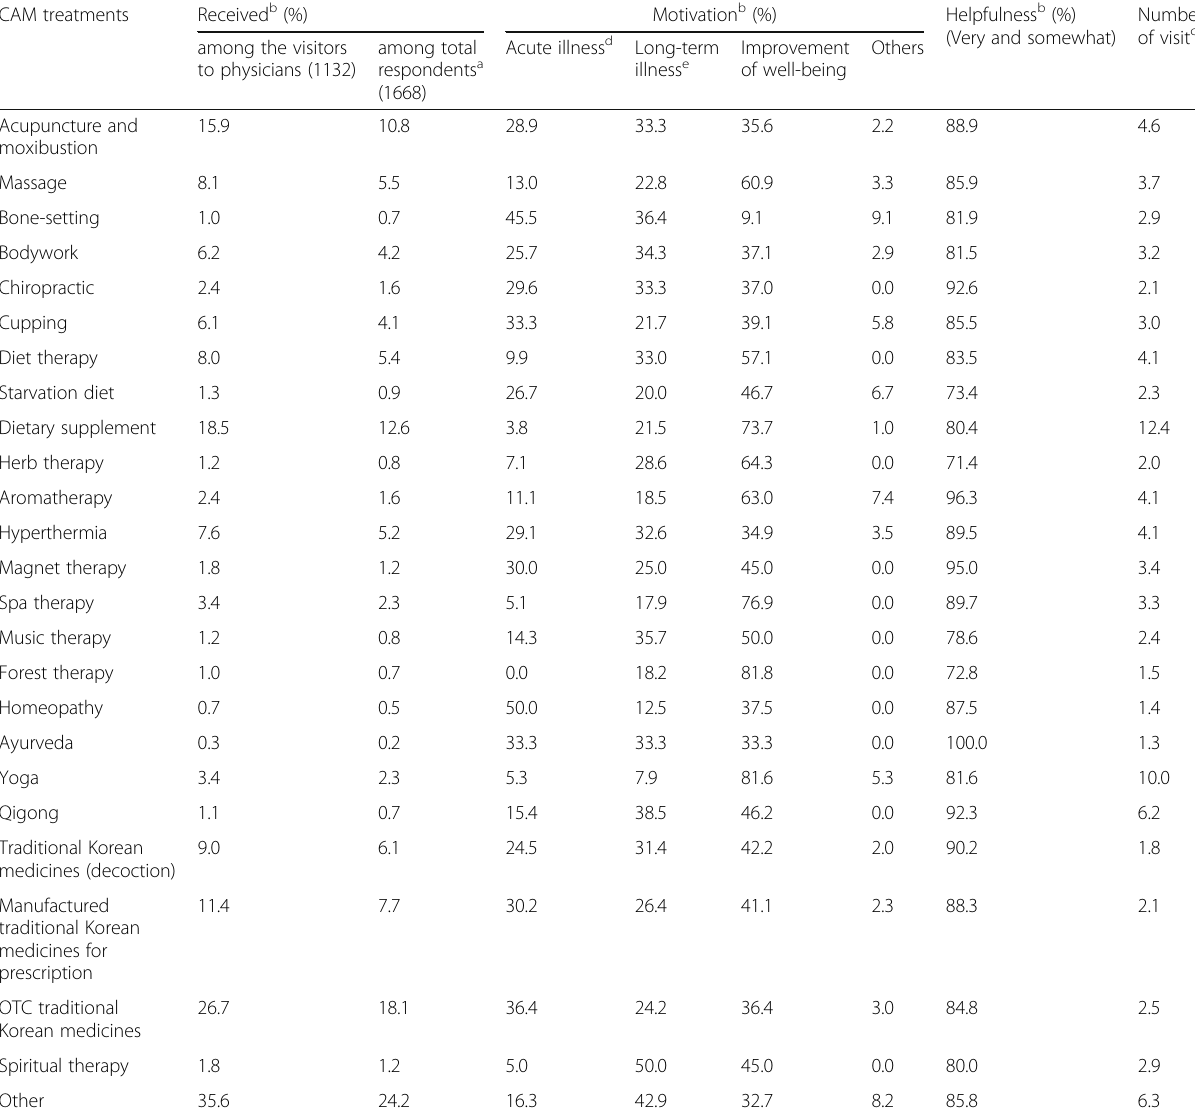
Table 3 CAM treatments received by practice or advices of physicians CAM treatments Received b (%) Motivation b